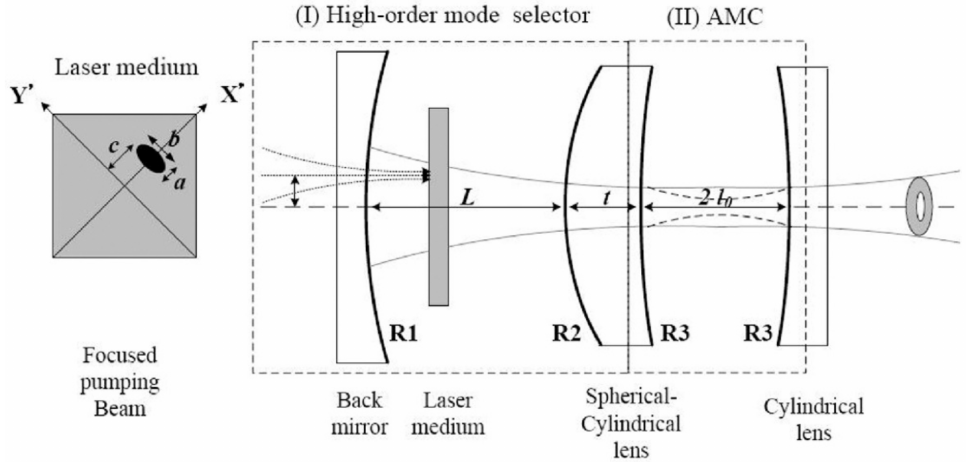
Figure 2. A Nd:GdVO 4 microchip laser with off-axis pumping and a mode converter [106]. Reprinted with permission from [106] © The Optical